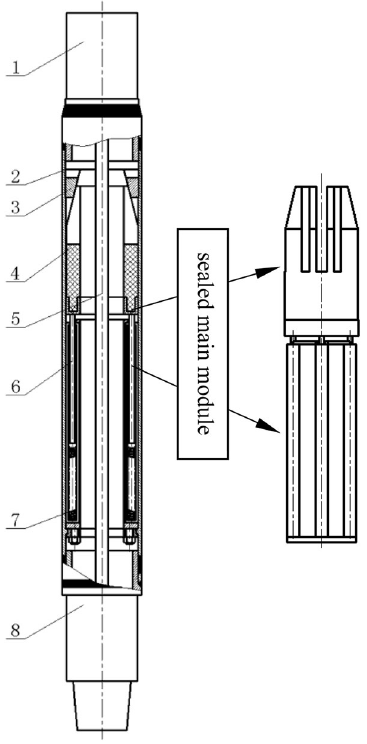
Fig. 6 Structure diagram of downhole safety equipment ( 1 -inner cone coupling short-connection, 2 -tubing ontology, 3 -guide cone, 4 - high-temperature sealed rubber sleeve, 5 -sucker rod, 6 -micro hydraulic cylinders, 7 -die spring, 8 -outer cone coupling short- connection)